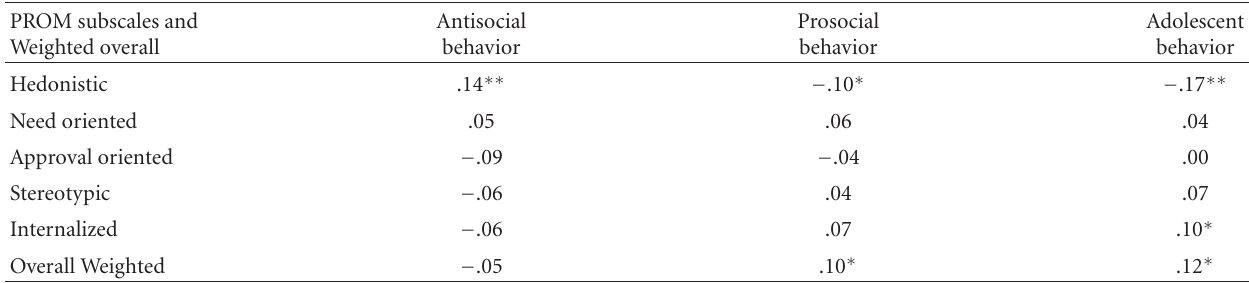
Table 3: Correlation between prosocial moral reasoning and prosocial/antisocial behavior in adolescents ( N = 566).